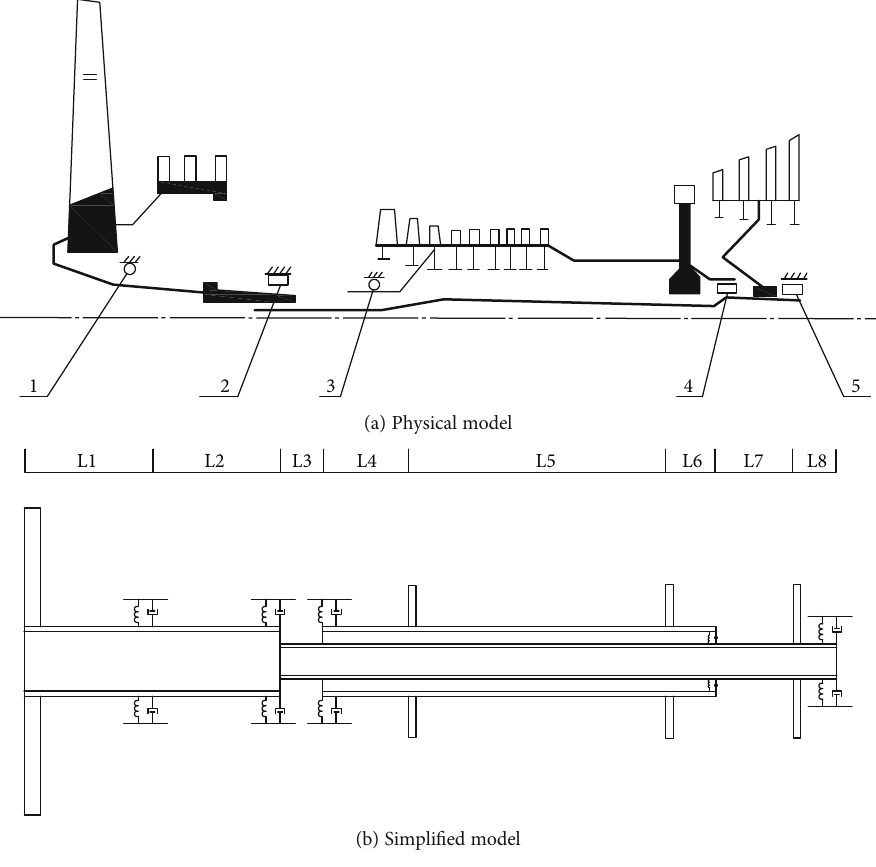
Figure 1: Dual-rotor system